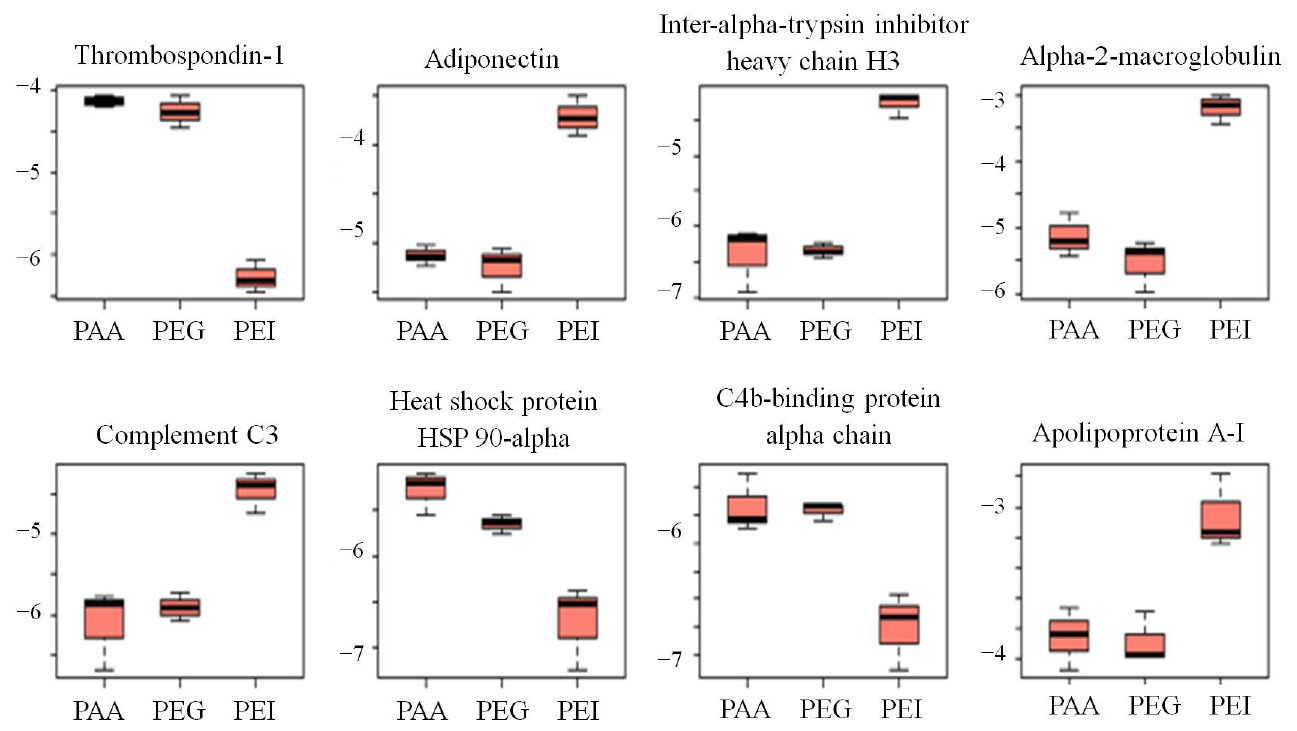
Figure 5. Box and whisker plots of the eight most-abundant proteins between the PC of the tested polymer-modified UCNP samples. The value of Log NSAF is plotted along the y -axis. The statistical significance was estimated using a Student’s t -test on the log-transformed NSAF values from the original biological triplicates ( p <